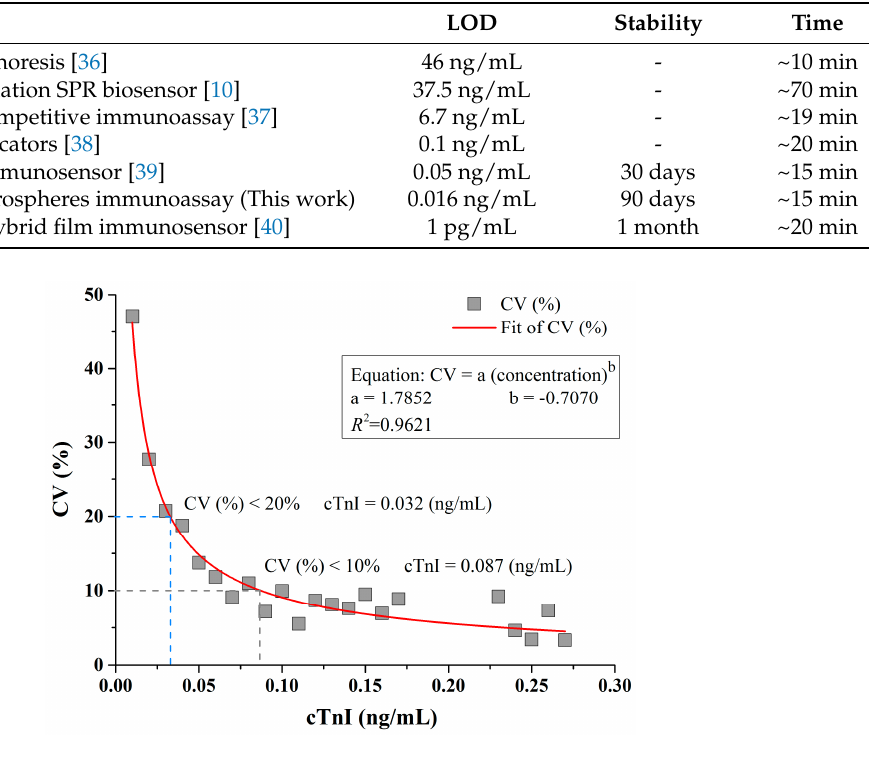
Figure 5. The cTnI concentration of LOQ at 10% CV and 20% CV from 0 to 0.30 ng/mL. Table 2. The comparison of limit of quantification (LOQ) for cTnI from reported literatures and current work.